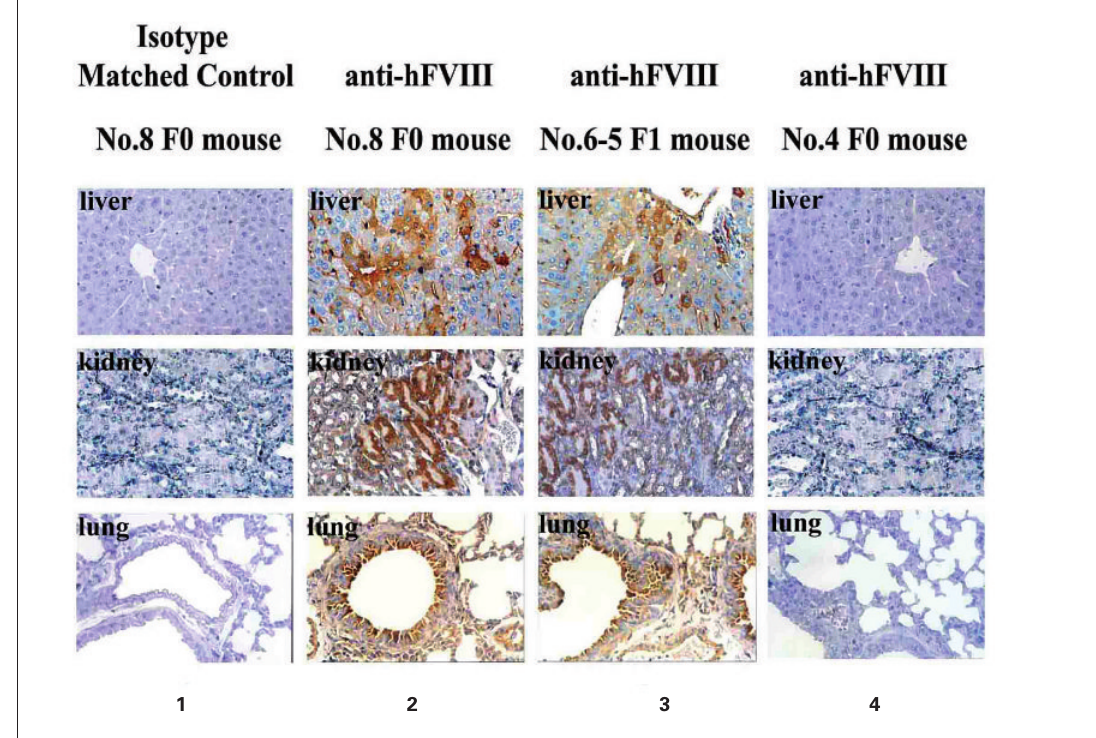
Figure 4 Immunohistochemi- cal staining for human FVIII in tis- sues from transgenic mice. Column 2, 3 and 4 were stained with anti-human FVIII anti- body, and column 1 was isotype matched control, which was stained in parallel by replacing anti-human FVIII antibodywith normal rabbit IgG. Staining was with DAB as chromogen and haematoxyllin restaining, x 400, brown-yellow sites demonstrated posi- tive hFVIII expres-